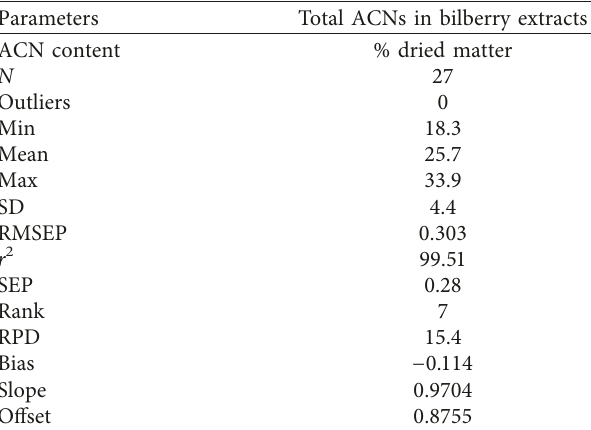
Table 2: Summary of the NIRS validation statistics.